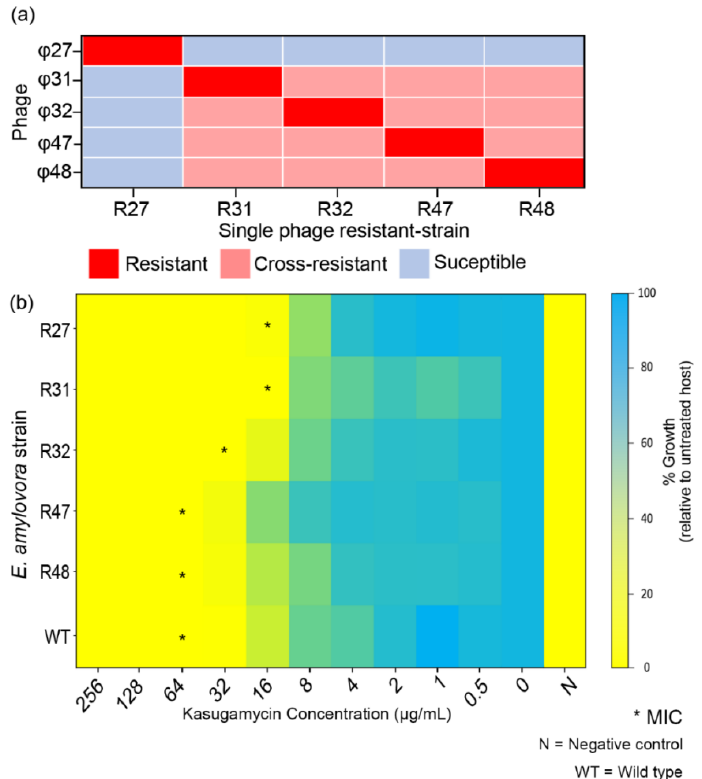
Figure 3. Biological characteristics of phage-resistant Erwinia amylovora TS3128. ( a ) Phage resistance profiles of the single phage-resistant strains. ( b ) Minimum inhibitory concentration (MIC) of kasug- amycin with the phage-resistant strains is indicated (*). WT and N indicate wild type and negative control (no bacterial ingredient), respectively.